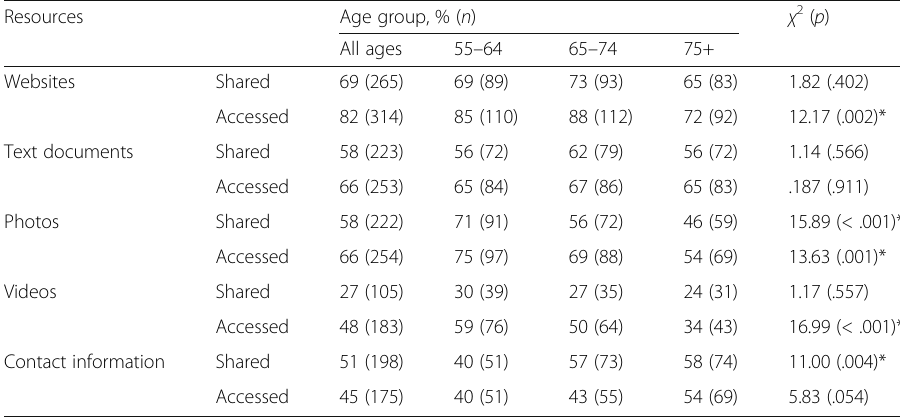
Table 1 Frequency of participants who share and access certain resources within their oPLN, by age group. Chi-squared analyses assessing the relationship between resource access/sharing and age. Significant analyses at the level of p < .005 are marked (*)